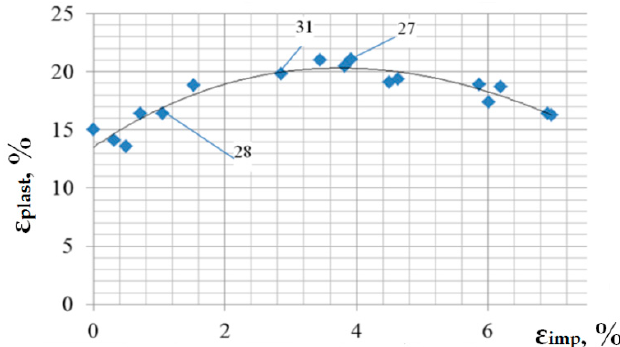
Figure 4. Dependence of plastic deformation of specimens from titanium alloy VT23 under static stretching ( ε plast ) on impulse deformation ( ε imp ) obtained under dynamic non-equilibrium processes (DNP).